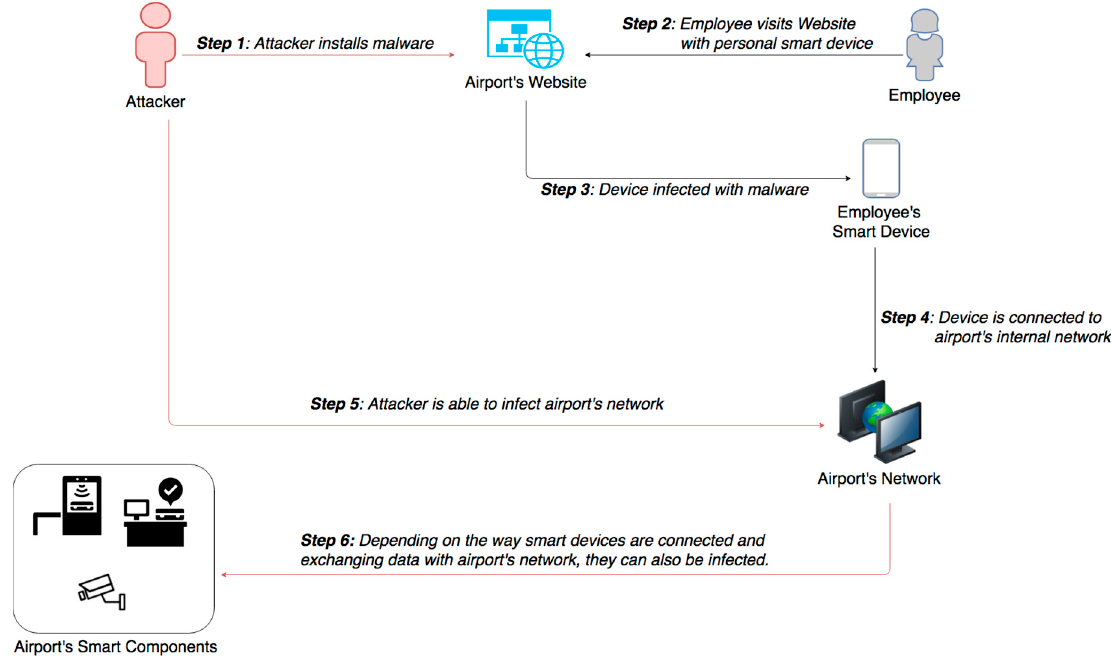
Figure 9. Malicious Software Installation.